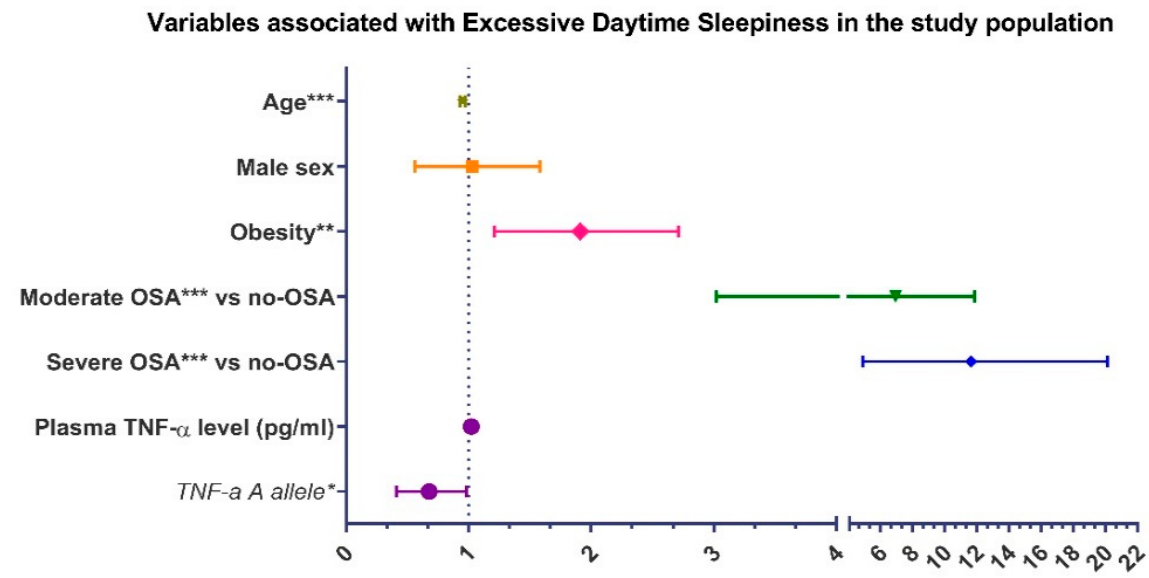
Figure 3. Variables associated with excessive daytime sleepiness in the study population in the multivariate logistic regression analysis. Abbreviations: TNF- α = tumor necrosis factor alpha; OSA = obstructive sleep apnea. * p < 0.05, ** p < 0.01, *** p < 0.001.